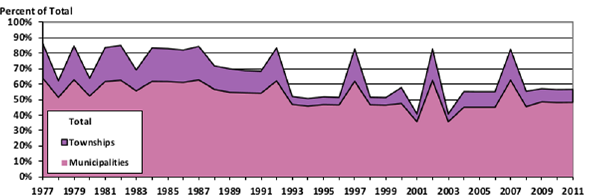
Fig 5. Population Coverage for Sampled Local Governments. This figure stacks together the population covered by municipalities and townships, and compares it to the population indicated at the state level for every year of the